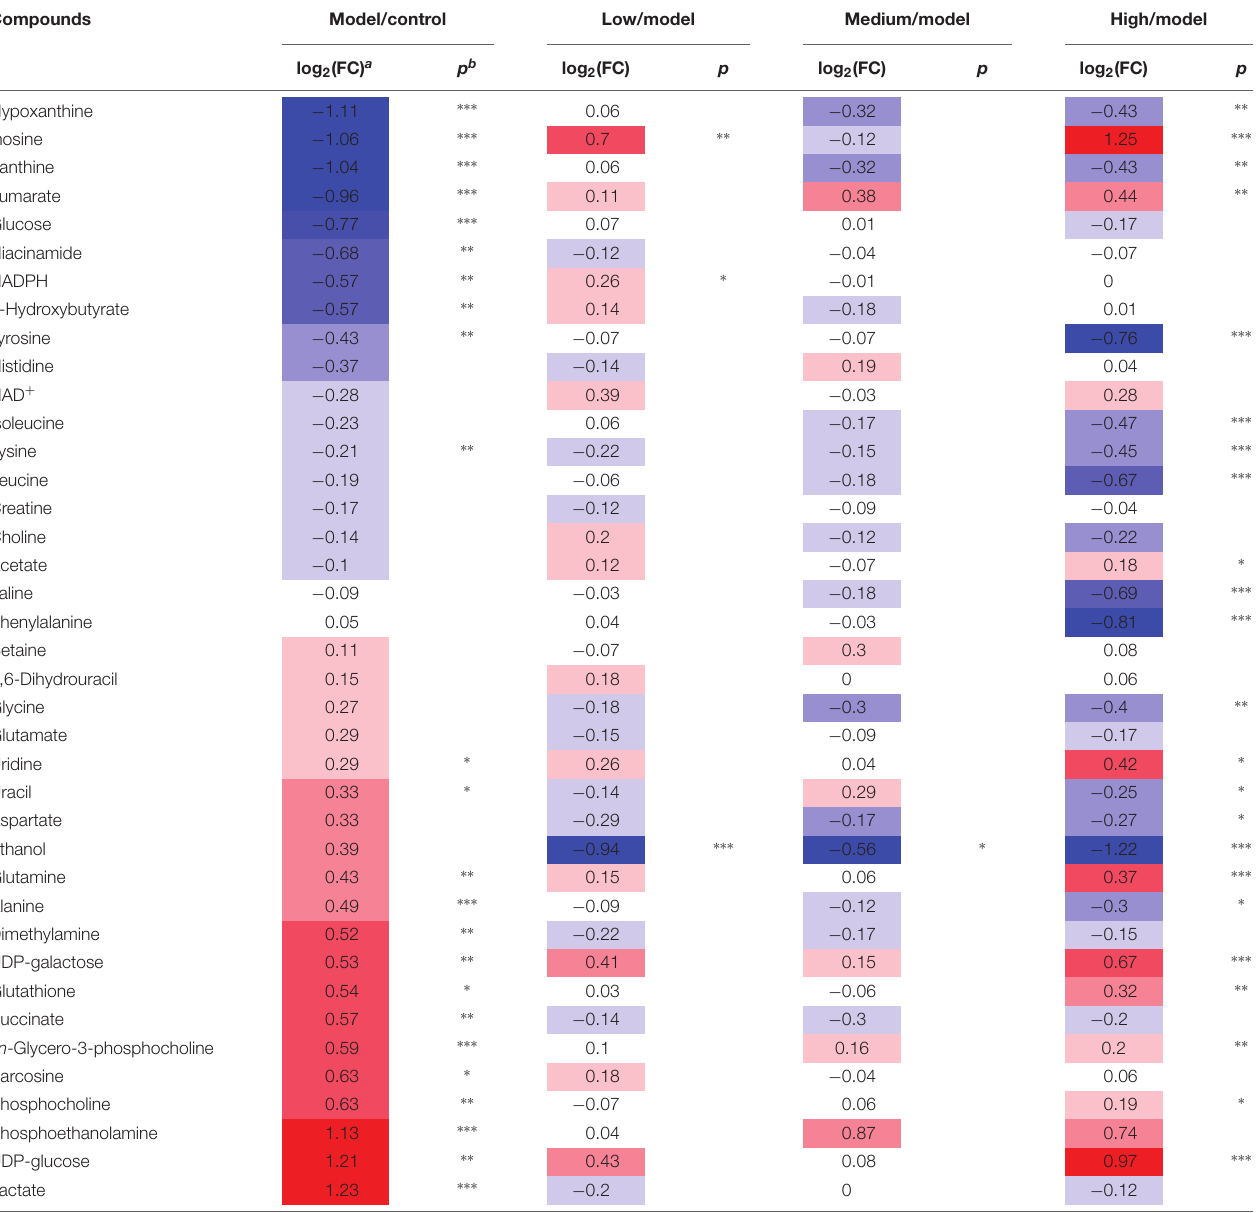
TABLE 1 | Potential marker metabolites in rat liver extracts identified by 1H-NMR and their 530 variations among groups and the associated p -values.